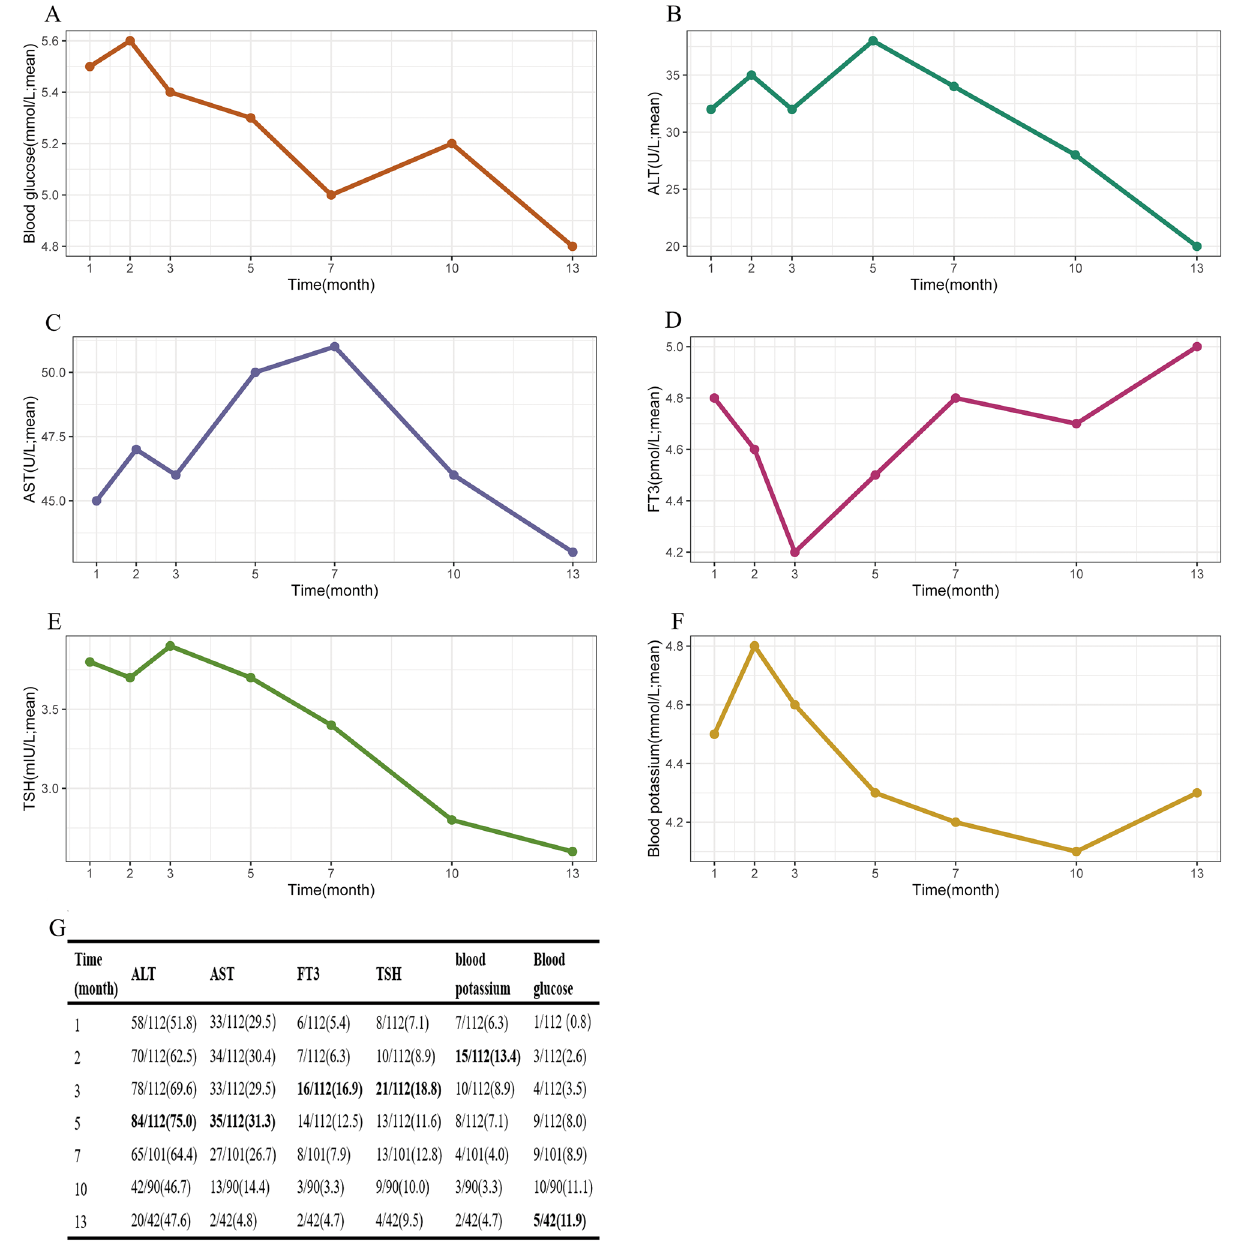
Figure 2. Changes of laboratory examination after propranolol during the outpatient follow-up; Change in mean blood glucose ( A ); Change in mean ALT and AST ( B,C ); Change in mean FT3 and TSH ( D,E ); Change in mean blood potassium ( F ); Abnormal laboratory test values in children during follow-up: bold values indicate the month with the highest incidence of abnormal values ( G ); ALT alanine transaminase; AST aspartate aminotransferase; FT3 free triiodothyronine; TSH thyroid stimulating